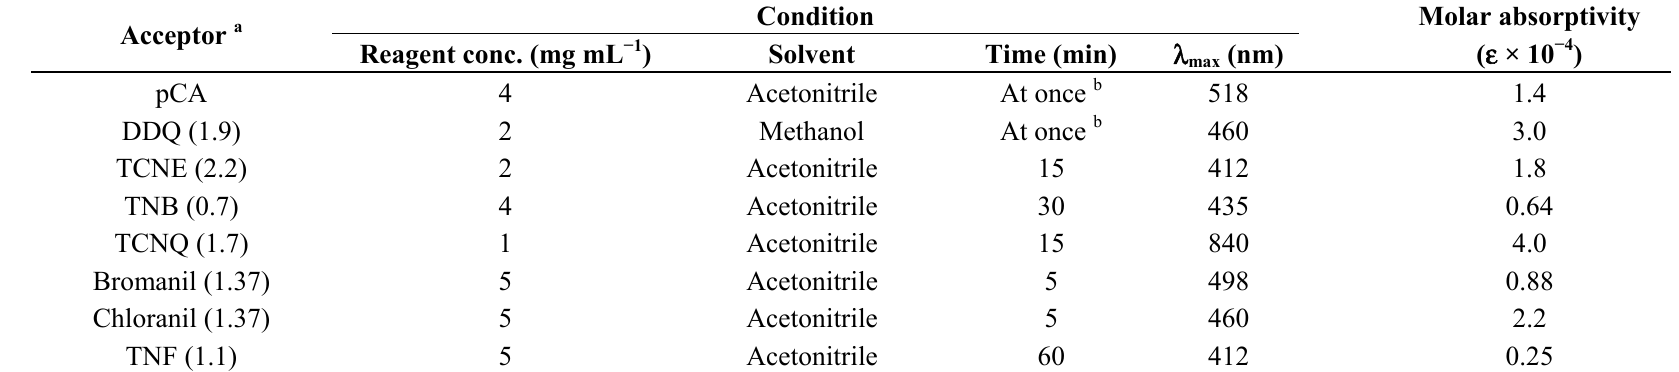
Table 1. Optimum conditions for the CT reaction of ROS-Ca with different π -acceptors and the achieved molar absorptivities.